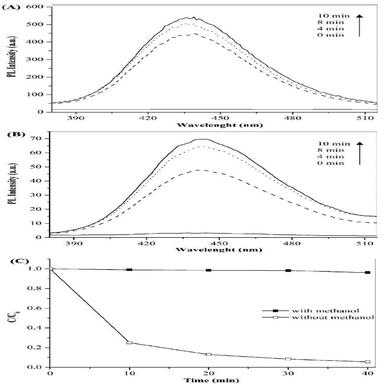
OH-trapping PL spectra of STA-12(Fe)/sunlight/H2O2 catalytic system, (a) in the absence dye; (b) in the presence of dye and (c) effect of methanol inhibitor on the degradation of MO.